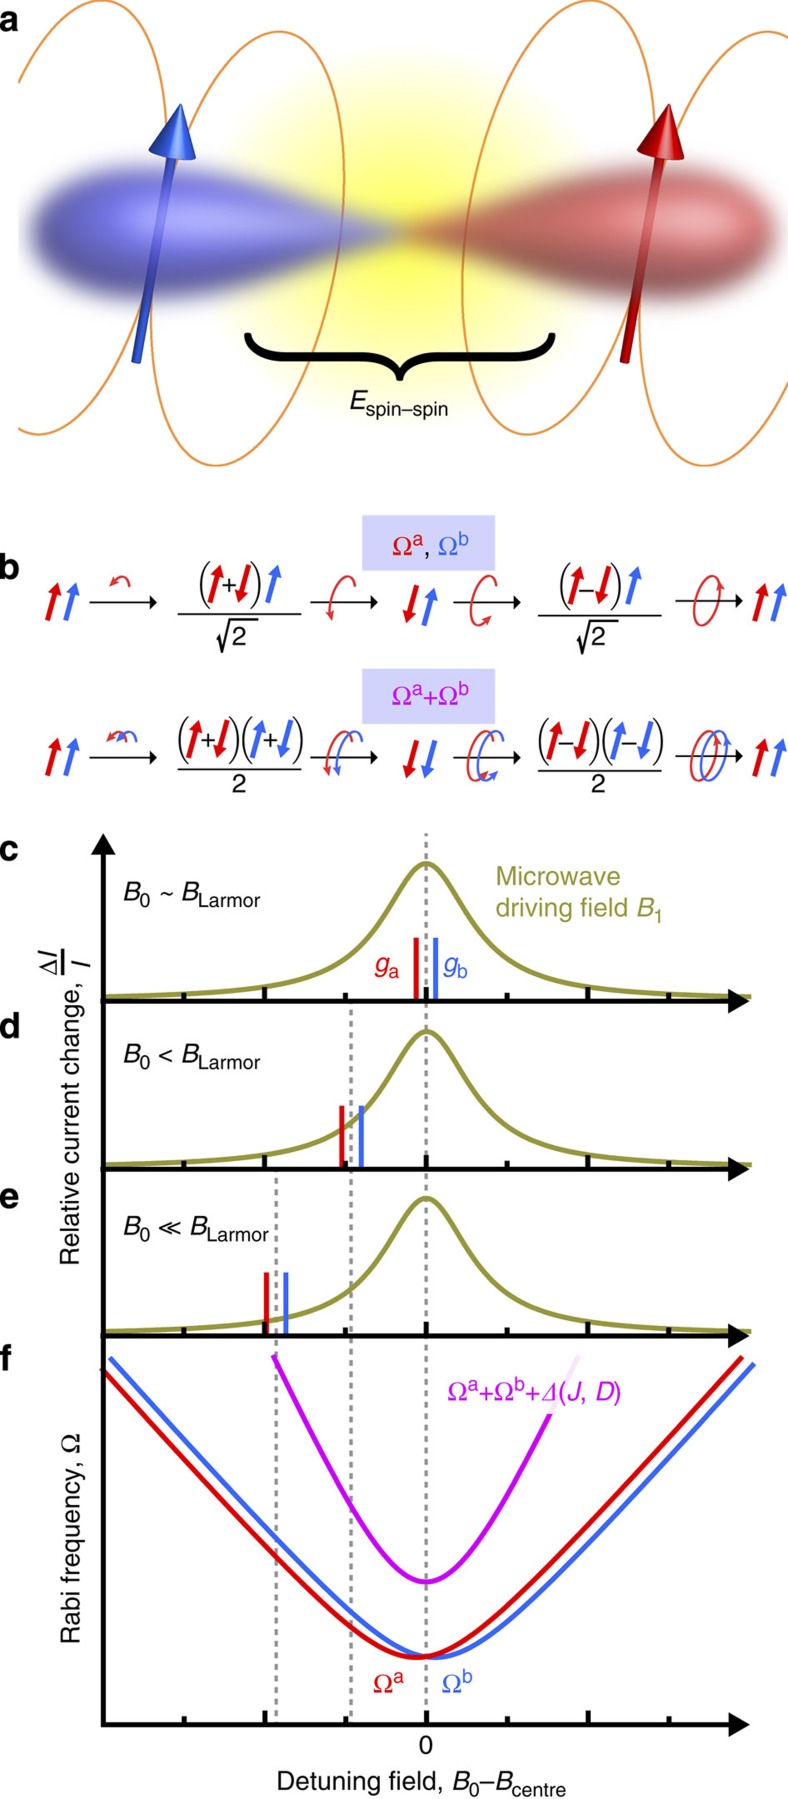
Probing carrier-pair spin–spin interactions by resonantly driving harmonic Rabi oscillations.(a) Spin–spin interactions within charge-carrier pairs arise from spin-exchange J and magnetic-dipolar coupling D. (b) Under magnetic resonance conditions, a weak oscillating driving field B1 forces the spin state of a single charge carrier into precession, while the pair partner at a shifted Larmor frequency is out of resonance and therefore left unperturbed. In contrast, when a strong driving field is applied, which exceeds the pair's average Larmor separation, both carriers oscillate simultaneously (c), producing a beat oscillation (the harmonic) within the pair. This spin beating is reflected in the measured current by spin-dependent charge carrier transitions (recombination and dissociation). As the static magnetic field, B0, which induces Zeeman splitting of the spin states, is detuned away from magnetic resonance of either pair partner (d,e), both the fundamental and the harmonic of the Rabi oscillation frequencies shift according to equation (1). (f) When spin–spin coupling is non-zero, the harmonic of the Rabi frequency acquires an additional shift Δ that depends on J and D.